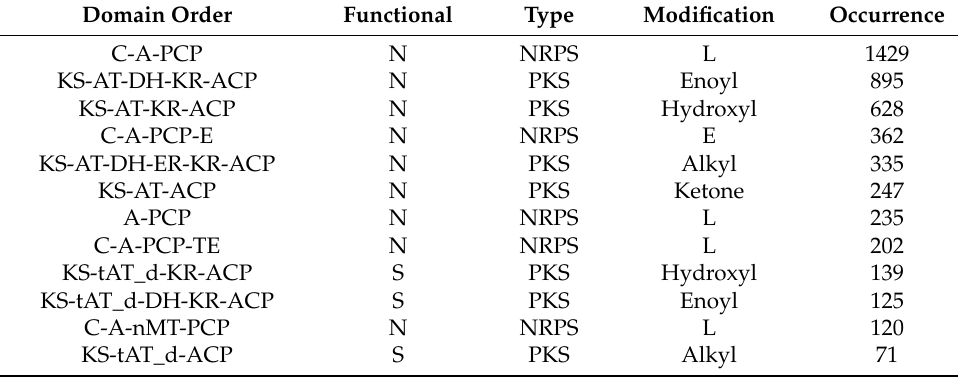
Table 2. The 20 most common modules found in the MIBiG. The functional classification, normal (N), special (S), and not functional (NF) is explained in Section 4.2. The modification refers to